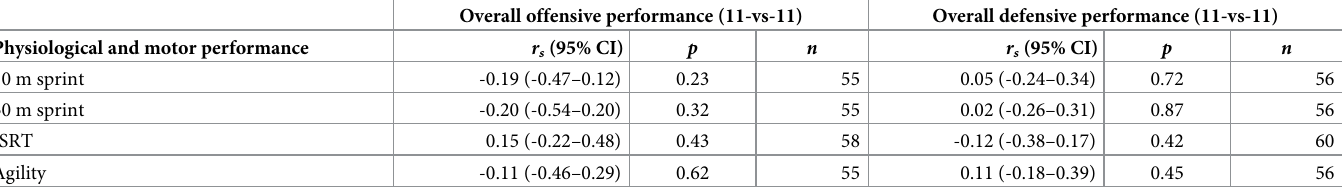
Table 5. Aggregated Spearman’s correlations between physiological and motor tests and overall offensive (left) and defensive performance (right) in 11-vs-11